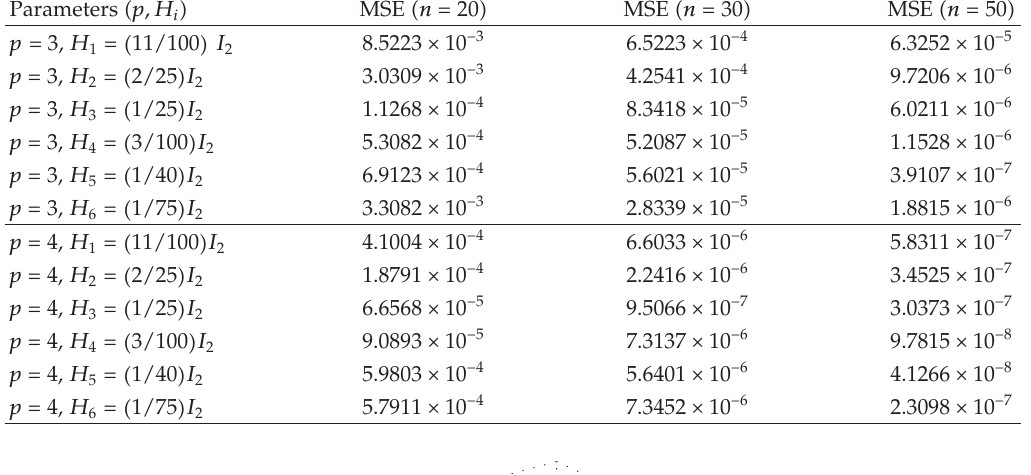
Table 1: Mean square errors (cid:2) MSEs (cid:3) with di ff erent values of p , H given n (cid:8) 20, 30, 50 in Example 4.1, I 2 : unit matrix of two orders.